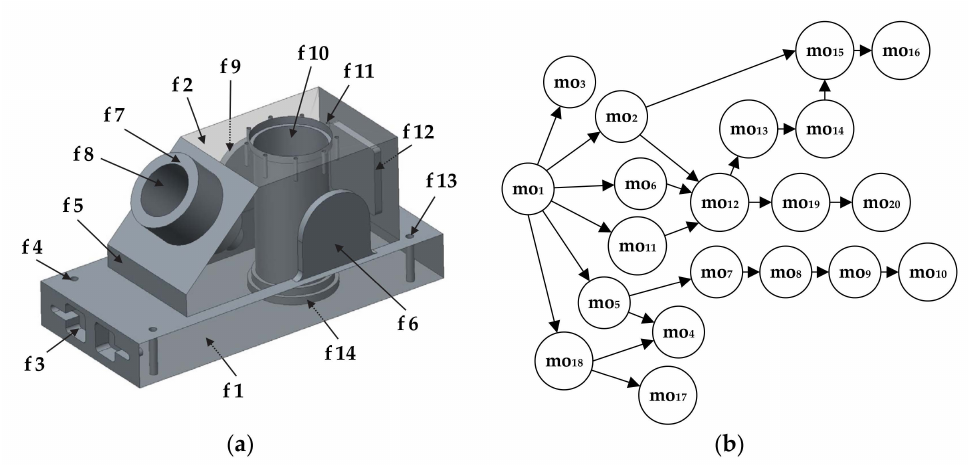
Figure 3. ( a ) Semi-transparent solid model and ( b ) the cOPG of the prismatic part